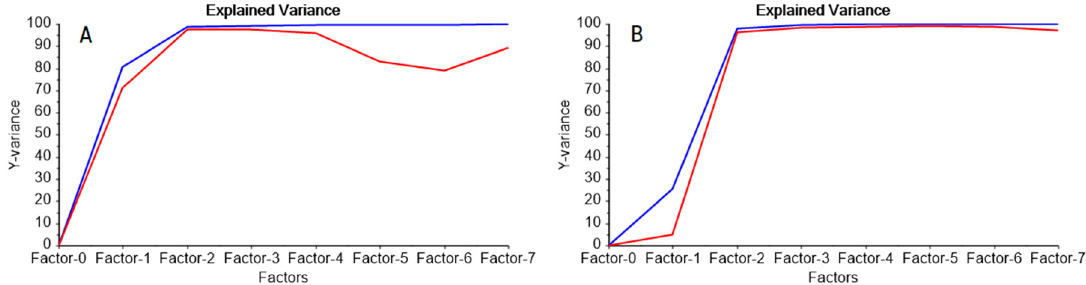
Figure 5. Percent of spectral variance explained by the VIS ( A ) and MID-FTIR ( B ) models as a function of the number of latent variables for calibration (blue) and cross-validation (red).